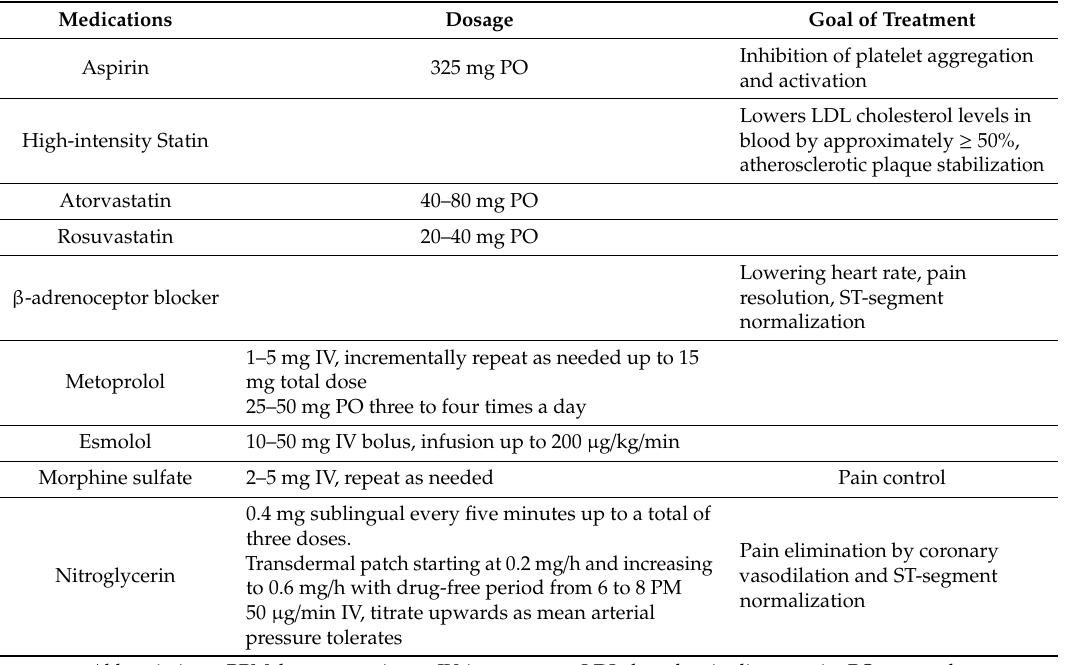
Figure 4. Management algorithm of postoperative NSTEMI. # Aspirin and clopidogrel is given in the postoperative period only when it is safe from surgical point of view. CTA, computed tomography angiography; 2D-ECHO, two-dimensional echocardiography; EKG, electrocardiography; NSTEMI, non-ST-elevation myocardial infarction; NTG, nitroglycerin. Table 4. Medical Therapy for NSTEMI following PPGL resection.